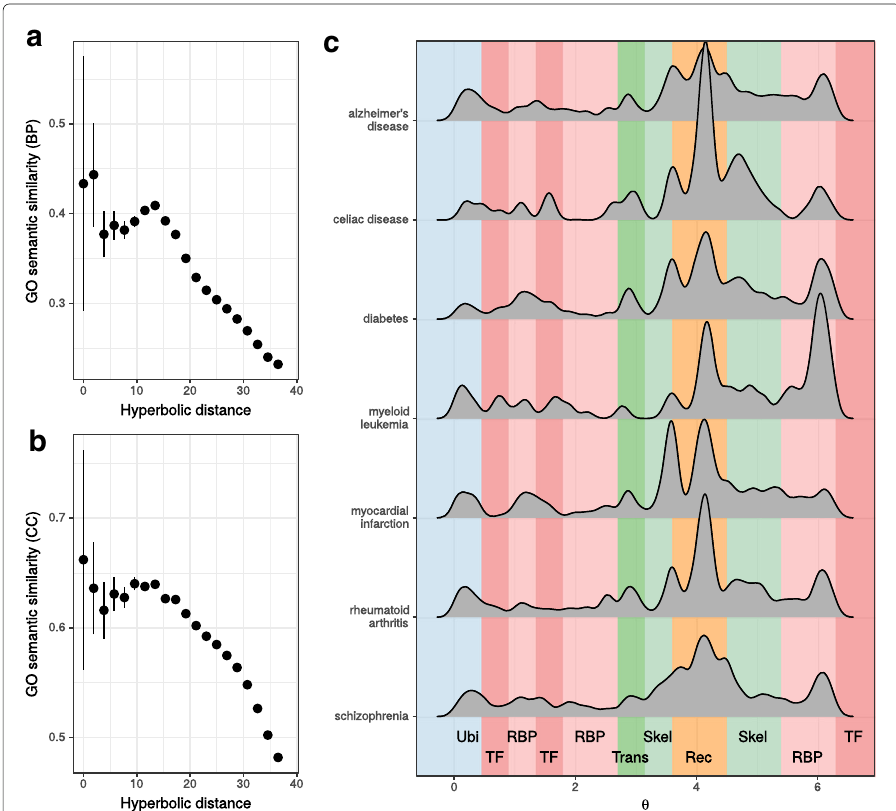
Fig. 2 Disease modules split into functionally distinct submodules. a . Gene Ontology (GO) semantic similarity of Biological Process (BP) terms that annotate proteins pairs spaced not further than the indicated hyperbolic distance. b . Same as a but for Cellular Component (CC) terms. c Angular distribution of disease proteins associated with 7 illnesses from our gene-disease association dataset. The coloured backgrounds indicate that one of 6 considered protein classes is over-represented in that angular range (Ubi: proteins involved in ubiquitination/proteolysis, TF: transcription factors, RBP: RNA-binding proteins, Trans: transporters, Skel: constituents of the cytoskeleton, Rec: